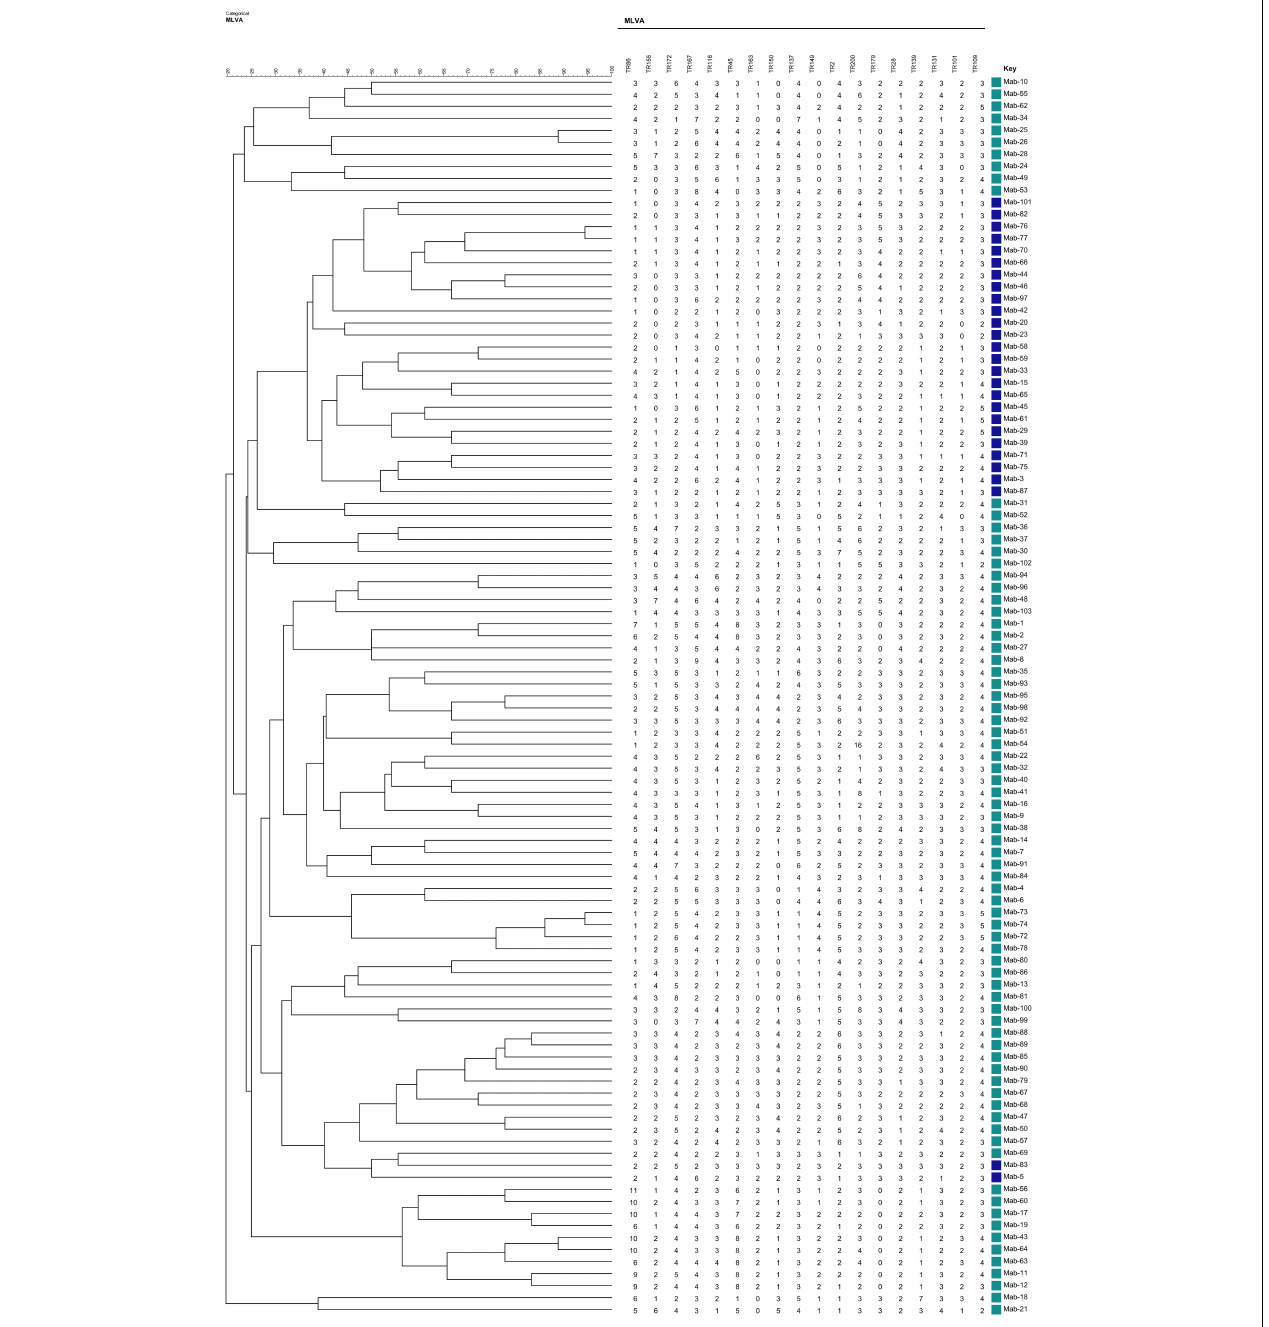
FIGURE 1 | Phylogenetic tree of 103 Mycobacterium abscessus complex (MABC) strains based on variable number tandem repeat (VNTR) typing created using the BioNumerics v5.0 (Applied Math) the unweighted pair group method with arithmetic mean